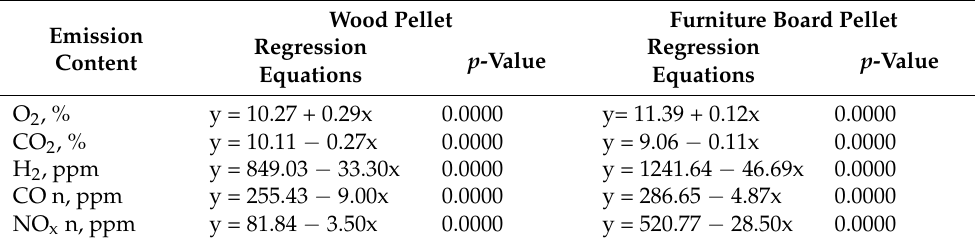
Table 5. Equations describing trend lines and the values of p